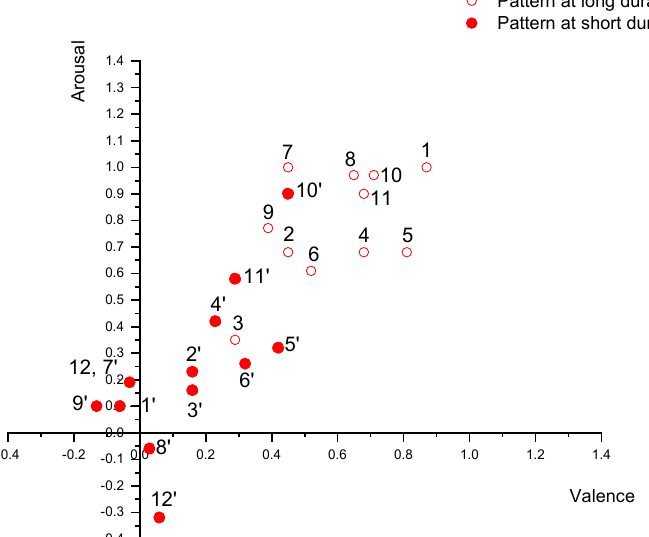
Figure 7. Emotional response due to change in duration at hot dynamic temperature. The apostrophe is used to describe the same pattern at the two states of duration; for example, pattern 1 at a long duration is represented by a circle enumerated as 1 and a short duration is represented by a filled circle enumerated as 1 ′ .